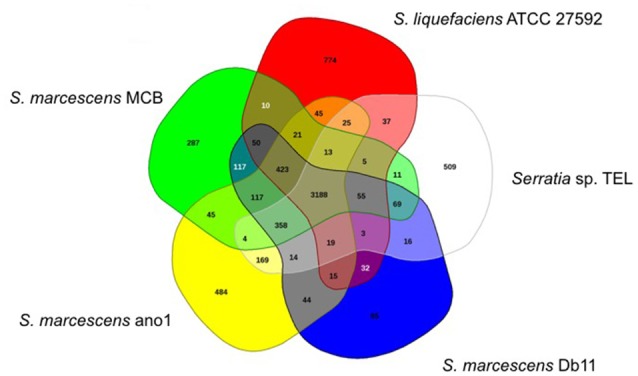
Venn diagram of shared and unique genes in the selected Serratia. The unique and shared genome among the compared genomes was determined by a dual cutoff of 30% or greater amino acid identity and sequence length coverage of at least 70%. Analysis was done using the MAUVE genome alignment tool. 1, S. liquefaciens; 2, S. marcescens MCB; 3, S. marcescens ano1; 4, S. marcescens Db11, and 5, Serratia sp. TEL.